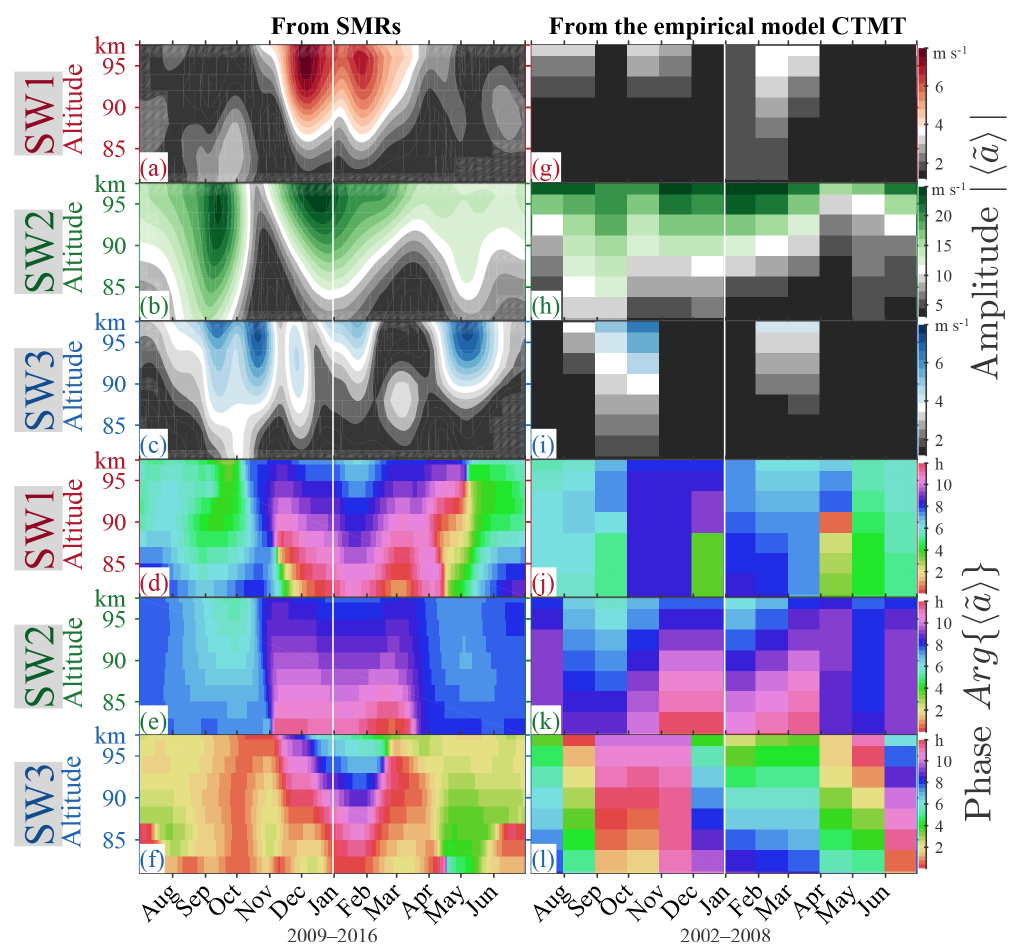
Figure 7. (a–c) Same plots as Figs. 4j, k, and l but for complex amplitude |(cid:104) e a (cid:105)| of SW1, SW2, and SW3, with their phases shown in (d) – (f) . (g–l) Similar plots to (a) – (f) but according to the climatological tidal model of the thermosphere (CTMT) derived from SABER and TIDI observations (Oberheide et al., 2011).